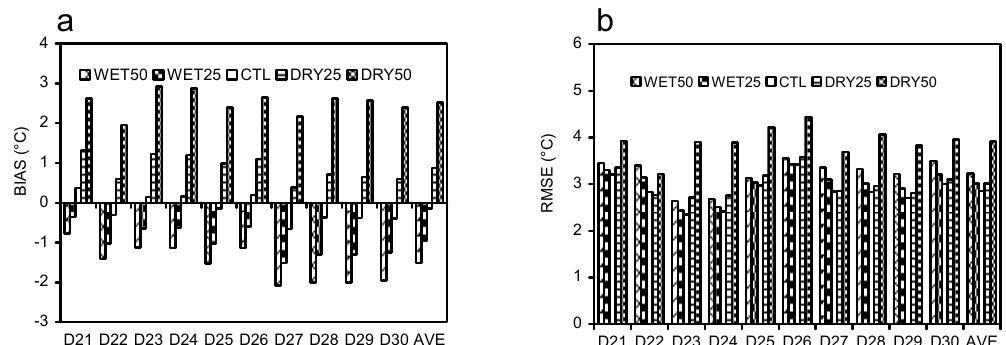
Figure 5. The BIAS (a) and RMSE (b) values for SAT06 in the individual simulations with a 10-day average